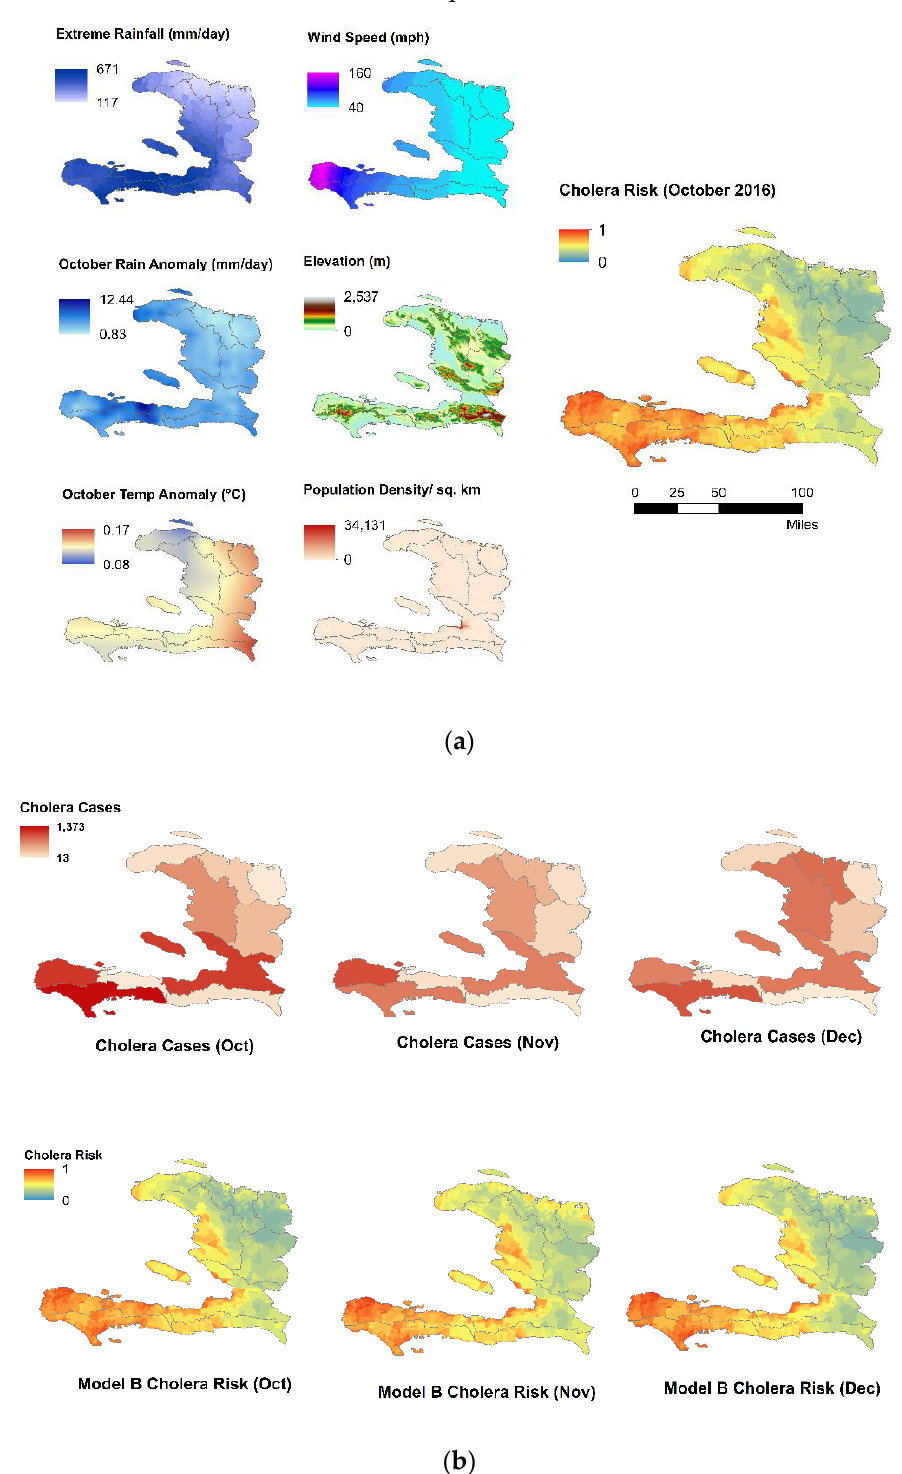
Figure 5. ( a ) Input variables and cholera risk prediction of Model B for October 2016. ( b ) Spatio- temporal change of reported cholera cases and cholera risk index of Model B.